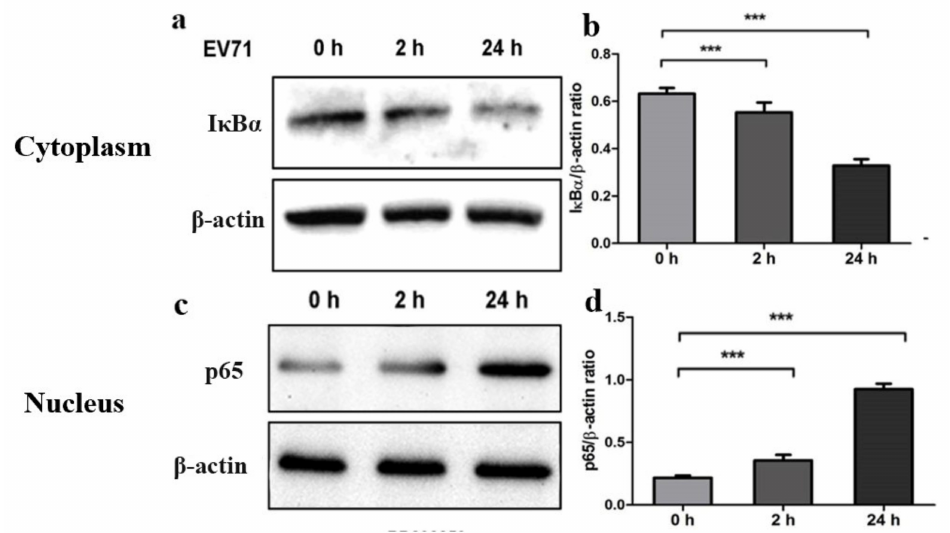
Figure 2. EV71 induced the activation of NF- κ B in U251 cell. ( a , c ) NF- κ B (p65) and IKB α were examined after EV71 infection, comparing with P65 and IKB α expressions at zero hours, two hours and twenty-four hours, respectively. IKB α and NF- κ B (P65) expression level detected by Western immunoblotting analysis. After infection, P65 was up-regulated dramatically in the nucleus, while the level of IKB α decreased within twenty-four hours ( p < 0.01). ( b , d ) IKB α /NF- κ B (p65) and β -actin ratio analysed by gray analysis of Western immunoblotting. *** p < 0.0001. To determine whether the EV71-mediated NF- κ B signaling pathway in the U251 cell could be regulated by ERK, the U251 cells were incubated with PD098059 (one kind of ERK inhibitors) for 60 min before being infected with EV71. cells were harvested at two hours and twenty-four hours post-infection. Western blot analysis was performed to detect NF- κ B (p65) both in the ERK inhibitor (PD098059) and control groups. Result showed that the levels of p65 increased in U251 cells with PD098059 (an ERK inhibitor) when compared to the control without PD098059 after EV71 infection (Figure 3b, p < 0.01). Results indicate that phosphorylation of ERK can trigger the activation of the NF- κ B signaling pathway in U251 cells infected with EV71 that could be blocked by adding an ERK inhibitor (PD098059).